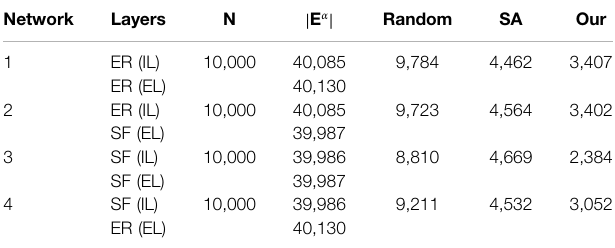
TABLE 1 | The size of constructed dominating set of duplex network coupled by different network layers Network